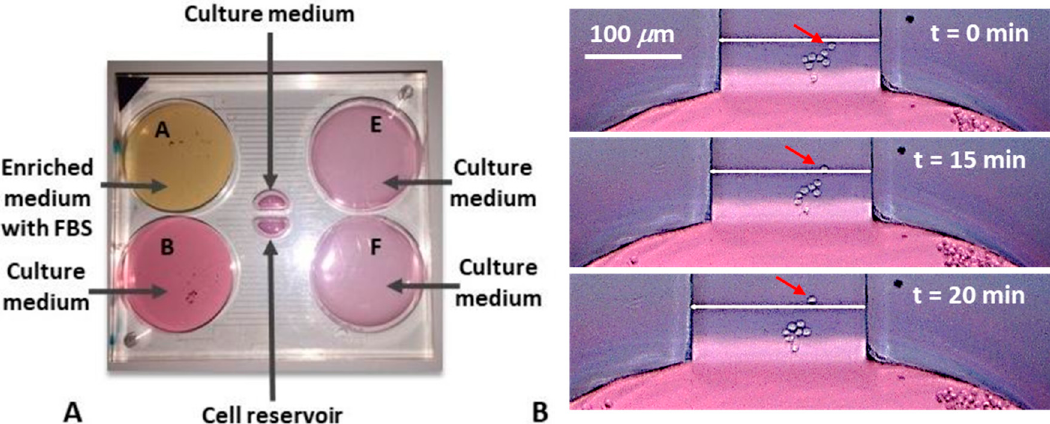
Figure 6. Cells media within the device ( A ); chemotaxis of a single cell ( B ). Cell movements could be observed after about 175 min. The average speed of cell movement was about 0.36 µm/min.